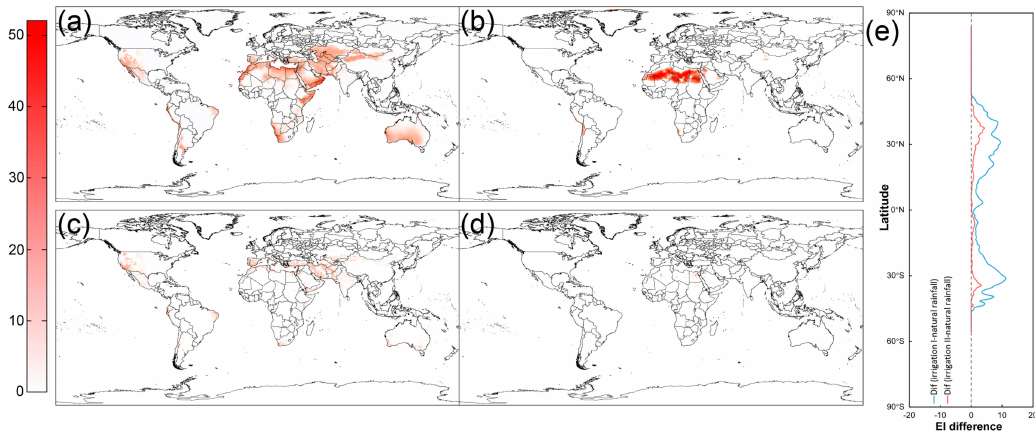
Figure 3. Impact of di ff erent irrigation scenarios on climatic suitability and average monthly precipitation. ( a ) Di ff erence between irrigation I and natural rainfall conditions on climatic suitability. ( b ) Di ff erence between irrigation I and natural rainfall conditions on average monthly precipitation. ( c ) Di ff erence between irrigation II and natural rainfall conditions on climatic suitability. ( d ) Di ff erence between irrigation II and natural rainfall conditions on the average monthly precipitation. Red indicates an increase; depth of color indicates the degree of change in EI values and average monthly precipitation. ( e ) Changes in EI di ff erence with increasing latitude; the blue line represents the di ff erence between irrigation I and natural rainfall; the red line represents the di ff erence between irrigation II and natural